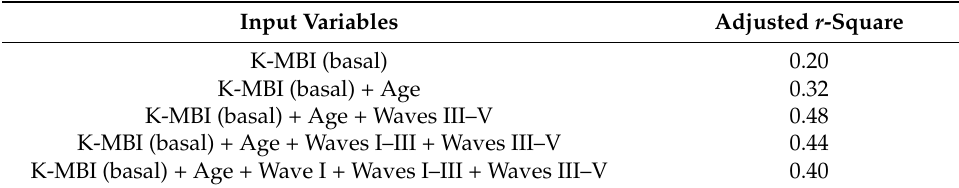
Table 5. Adjusted r -squares in stepwise